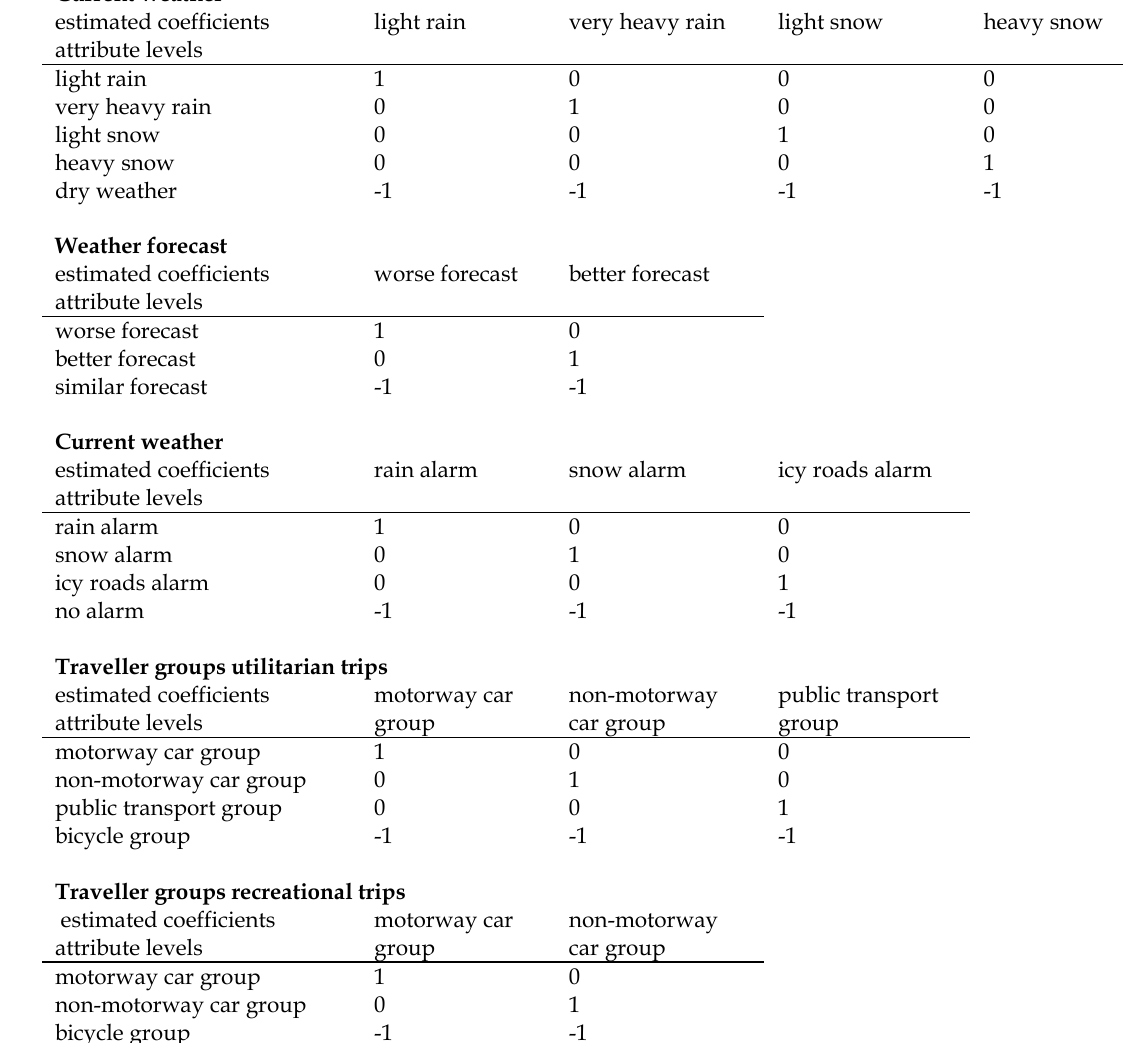
Table 1. Effects coding of the attribute levels and traveller